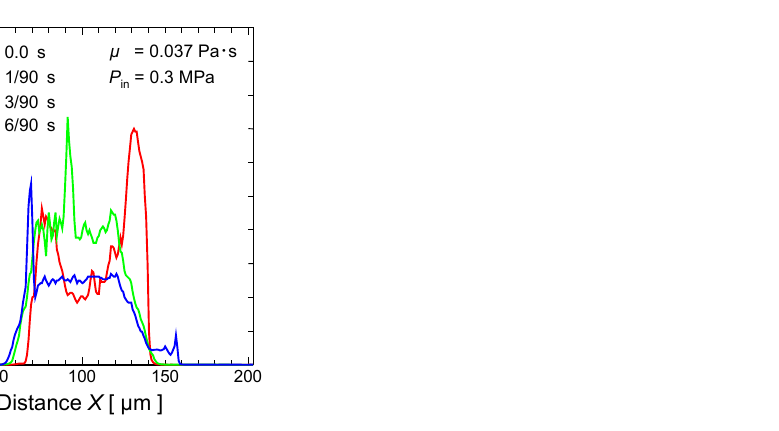
Figure 5. Fluorescent and pseudo-color images of the paint droplet.